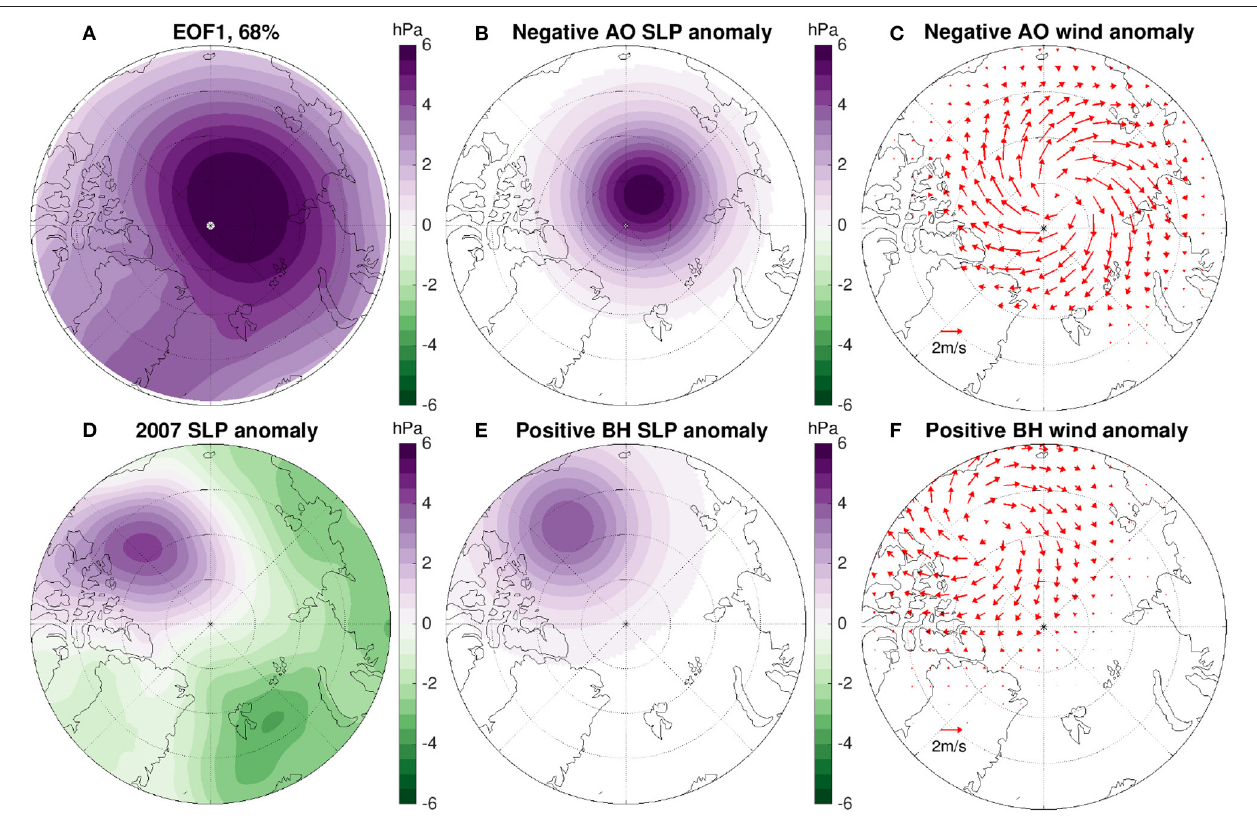
FIGURE 3 | (A) The first empirical orthogonal function (EOF) of sea level pressure (SLP, north of 70 o N) for the period 1980–2019. It resembles the pattern of the negative, anticyclonic Arctic Oscillation (AO) phase. (B) Idealized SLP anomaly representing negative AO and (C) the associated wind anomaly. (D) 2007 SLP anomaly relative to the mean over 1980–2019. It shows a strong positive Beaufort High (BH) SLP anomaly. (E) Idealized SLP anomaly representing positive BH anomaly and (F) the associated wind anomaly.